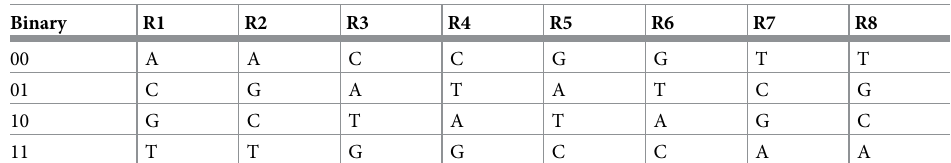
Table 2. DNA coding rules.